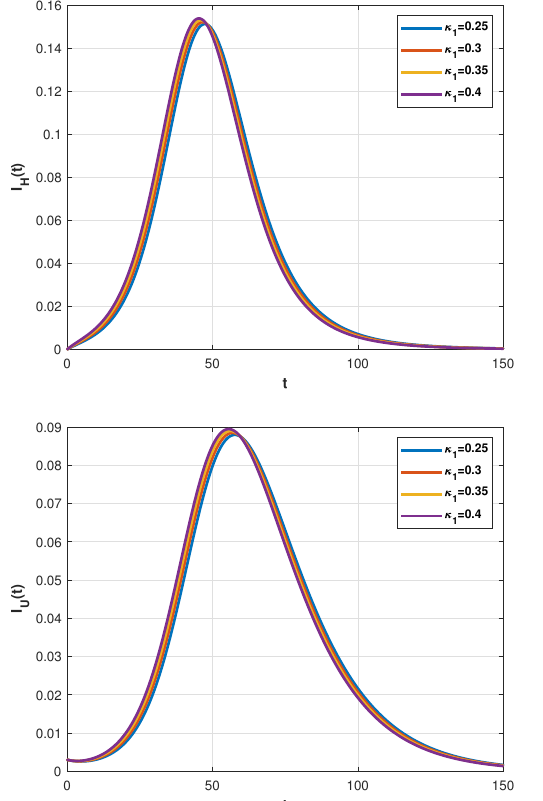
Fig. 7: Number of infected populations for different values of κ 1 , where other parameters are fixed κ 2 = 0 . 2 , α 1 = 2 , α 2 = 3 , ε 1 = 0 . 67 , ε 2 = 0 . 06 , ε 3 = 0 . 06 , µ H = 0 . 00004 , µ V = 0 . 07 , µ U = 0 . 07 , β 1 = 0 . 35 , β 2 = 0 . 9 , λ = 0 . 235 , γ = 0 . 16 , θ 1 = 0 . 33 , θ 2 = 0 . 3 .